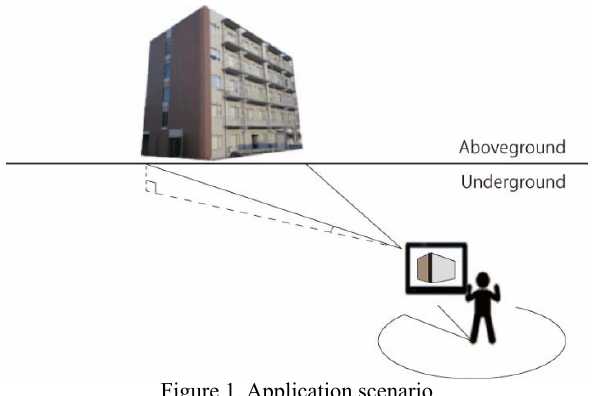
Figure 1. Application